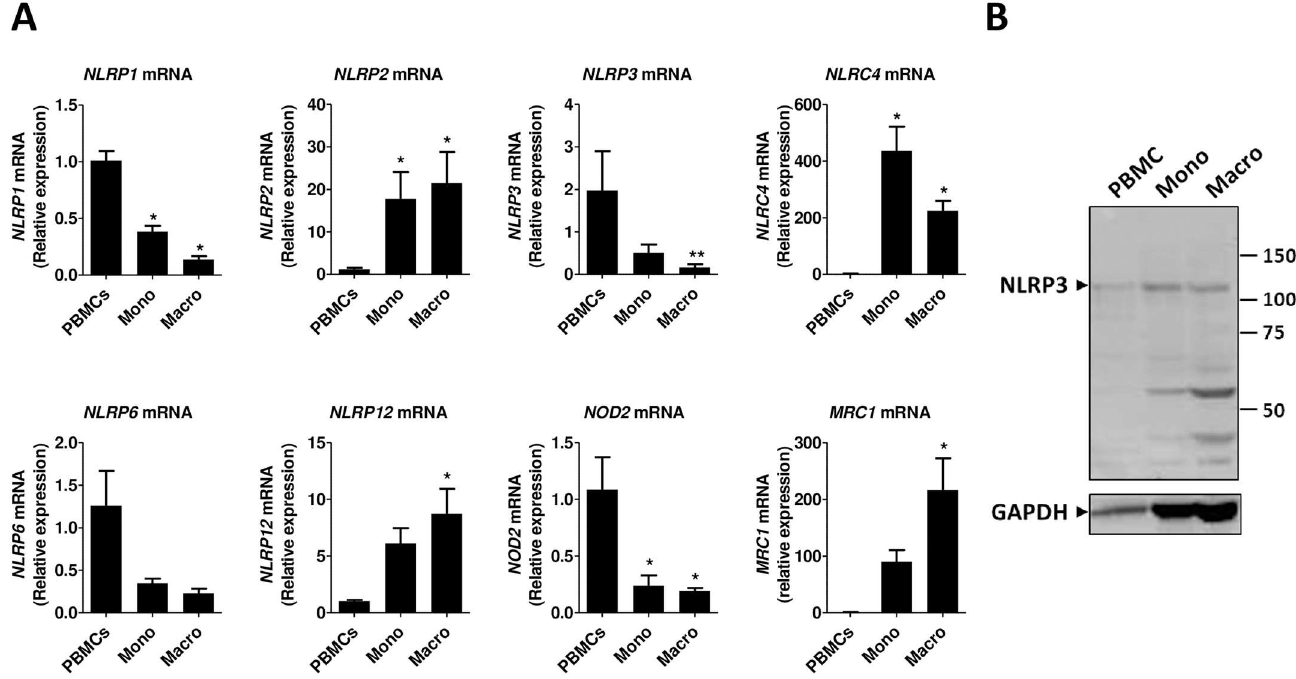
Fig 1. NLR expressionin human PBMCs, monocytes and macrophages. (A) mRNA gene expressionwas measuredby RT-qPCR and presented as relative fold changeof PBMCs. Data represent the mean ± standard error of the mean (SEM) of (cid:21) 4 experimentsperformed in duplicatein cells isolated from (cid:21) 4 independent donors. Mono: monocytes; Macro: macrophages. Asterisks indicatesignificantdifferences as comparedto PBMCs (Mann Whitney test: * p < 0.05; ** p < 0.01). (B) Western blot analysisin total lysates of human PBMCs, monocytesand macrophages using anti- NLRP3 antibody.GAPDH was used as loadingcontrol. The blot shown is representativeof at least 5 experiments from independentdonors. Mono: monocytes; Macro: macrophages.